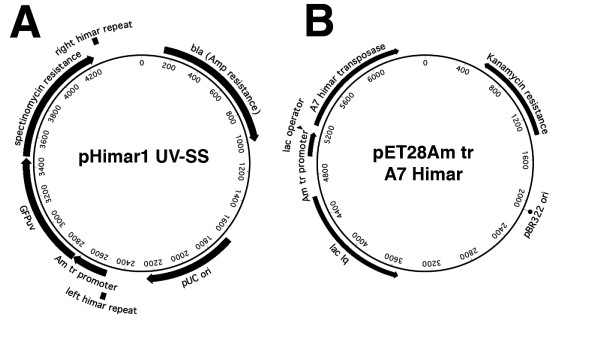
Physical maps of the Himar1 transposon and transposase plasmids. (A) pHIMAR1-UV-SS carries the A. marginale promoter tr driving expression of GFPuv and spectinomycin resistance between the left and right Himar transposon repeats. (B) pET28AMTR-A7-HIMAR contains the A7 hyperactive mutant of the Himar1 transposase also driven by the Am tr promoter.